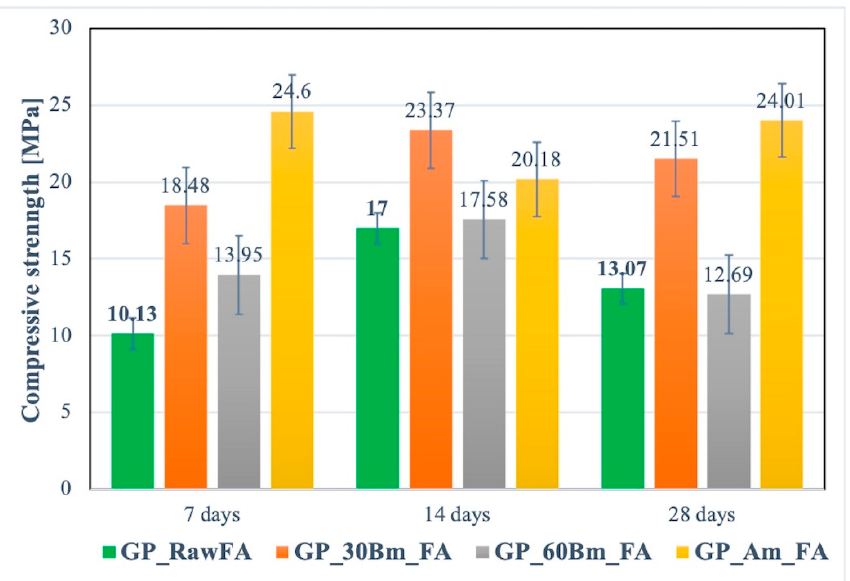
Figure 9. Compressive strengths of the various geopolymers. Error bars represent the standard deviation of a data.